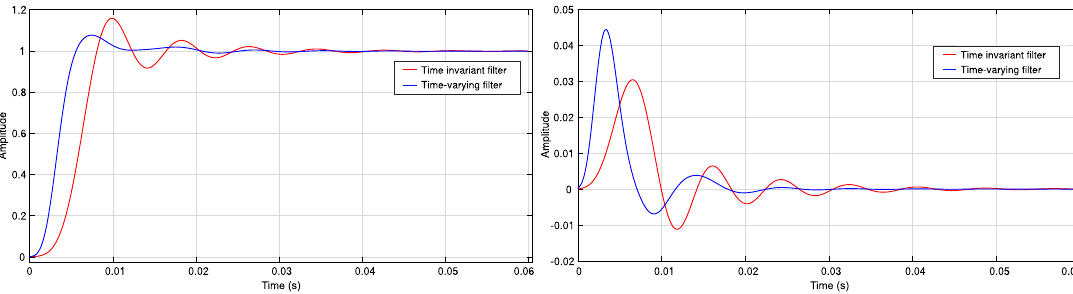
Figure 8. Step and impulse response of time invariant and discrete time-varying filter 125